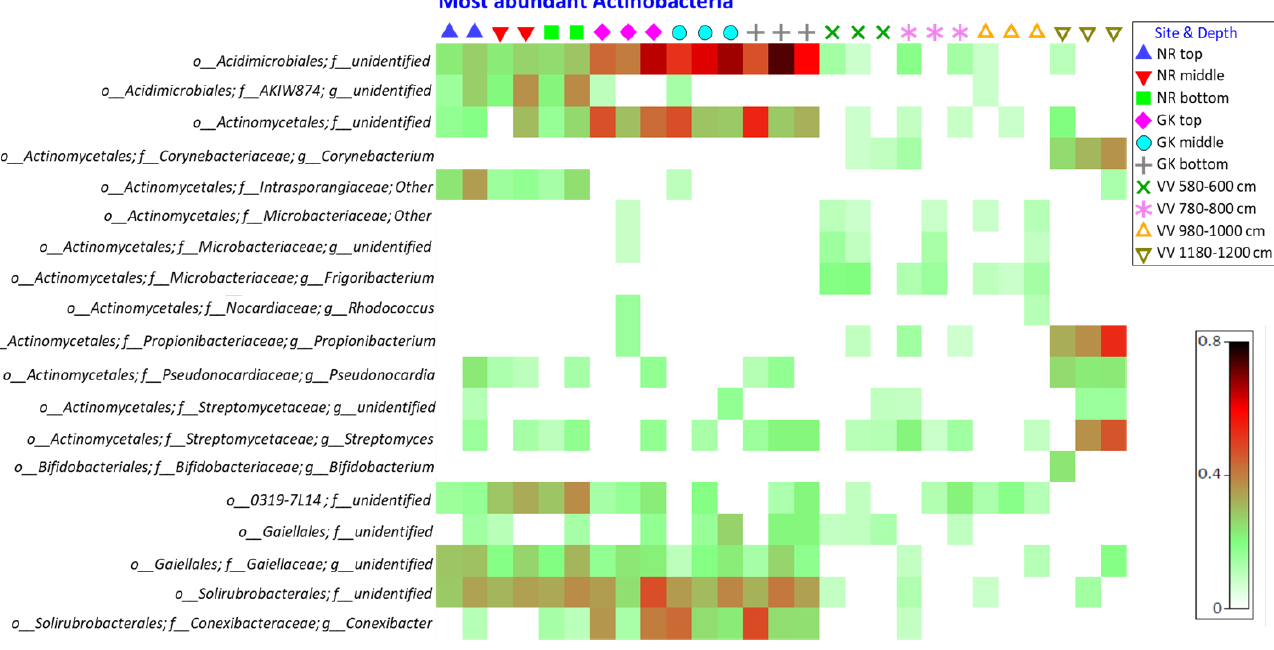
Figure 1. Shade plot of square root transformed relative abundance of the most abundant actinobacterial operational taxonomic units in the peat samples collected from the three study sites. NR = Nuwejaars River system (developing peatland); GK = Goukou River system (impacted peatland); VV = Vankervelsvlei (undisturbed peatland). Top: samples from 0 to 5 cm depth; middle: samples from 25 cm depth; bottom: samples from 50 cm depth. o = order; f = family; g = genus. Table 1. Representative actinobacterial taxa in peat samples as determined by indicator species analysis. Taxa with the highest frequency for each site are highlighted. o = order; f = family; g = genus; NR = Nuwejaars River system (developing peatland); GK = Goukou River system (impacted peatland); VV = Vankervelsvlei (undisturbed peatland).